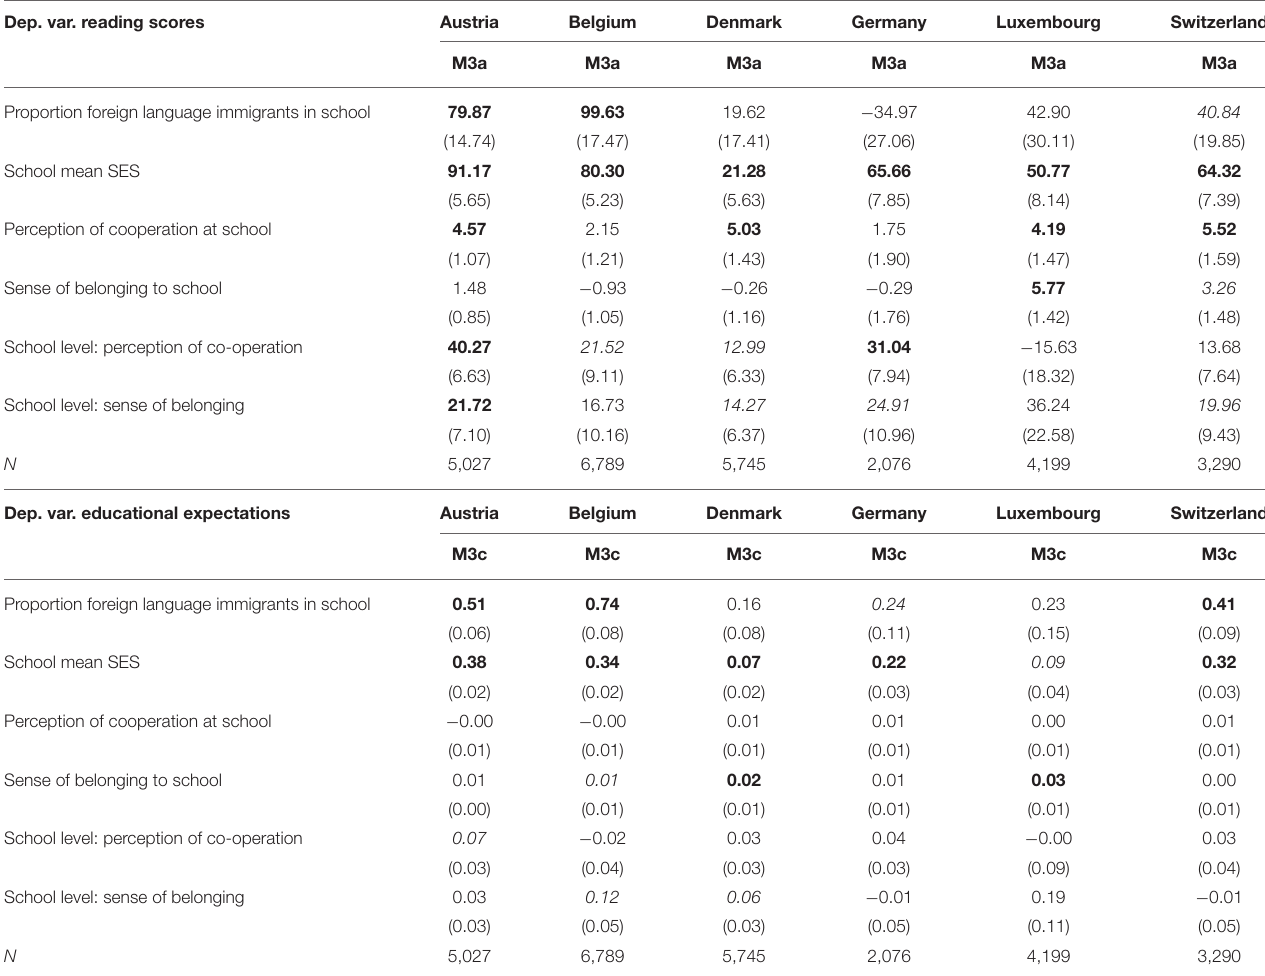
TABLE 7 | School-related predictors of reading scores (upper panel) and educational expectations (lower panel). Dep. var. reading